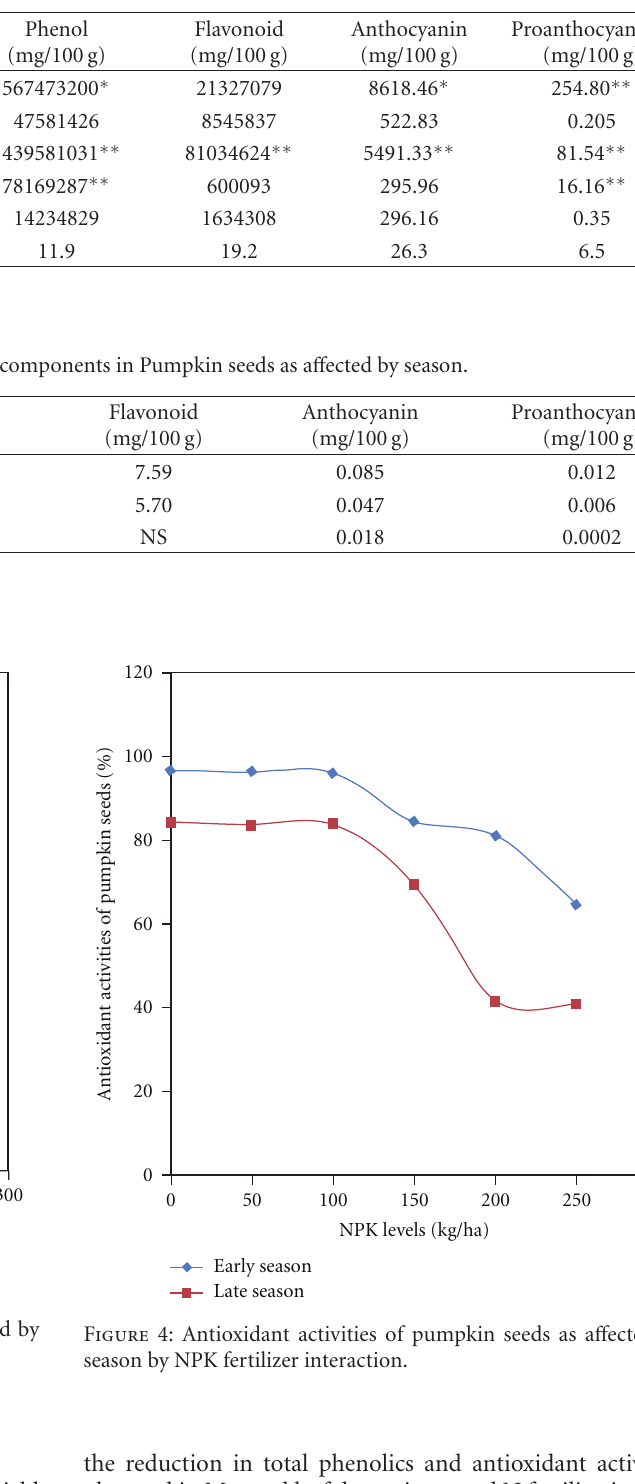
Table 4: Combined analysis of variance showing means squares for antioxidant activities and its components in Pumpkin seed as influenced by season and NPK fertilizer.